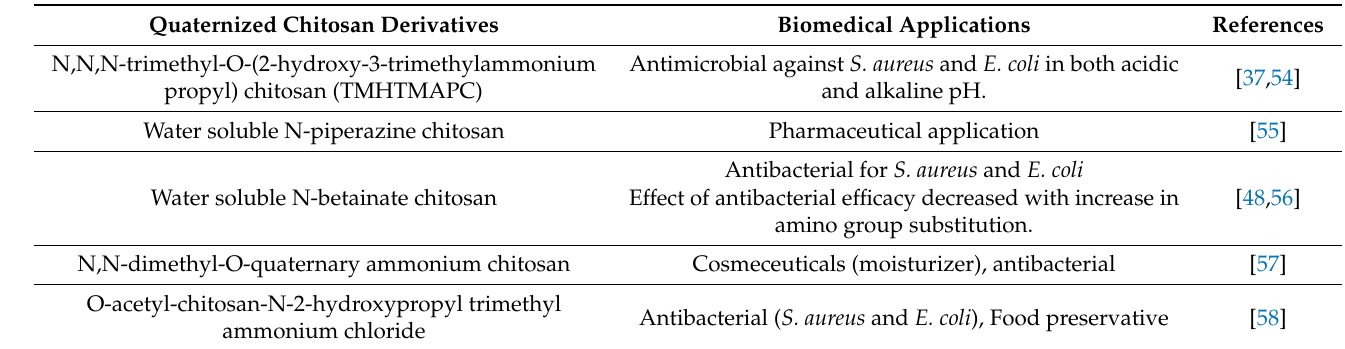
Figure 9. Structural illustration of different QCh derivatives and their biomedical applications. Table 2. Newly introduced quaternized chitosan derivatives and their biomedical application. Quaternized Chitosan